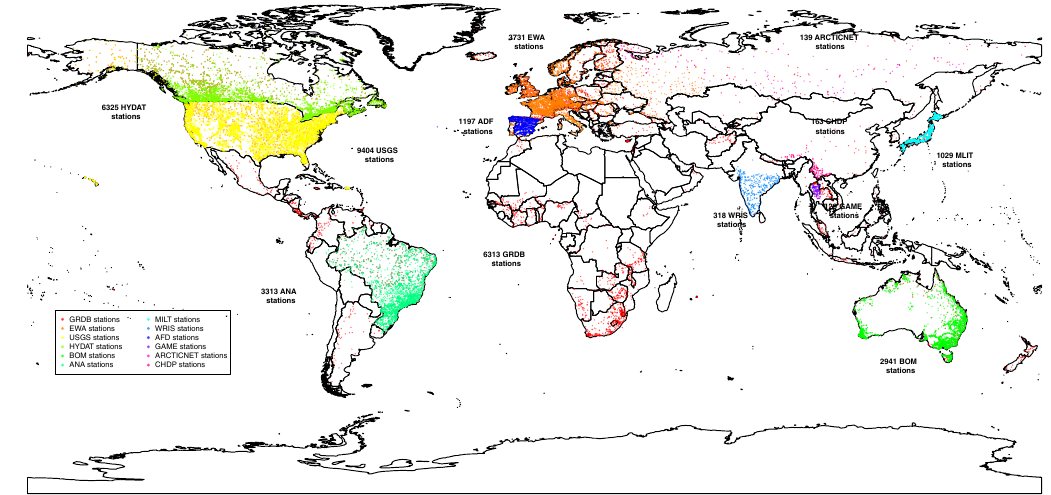
Figure 1. The distribution of stations from original data